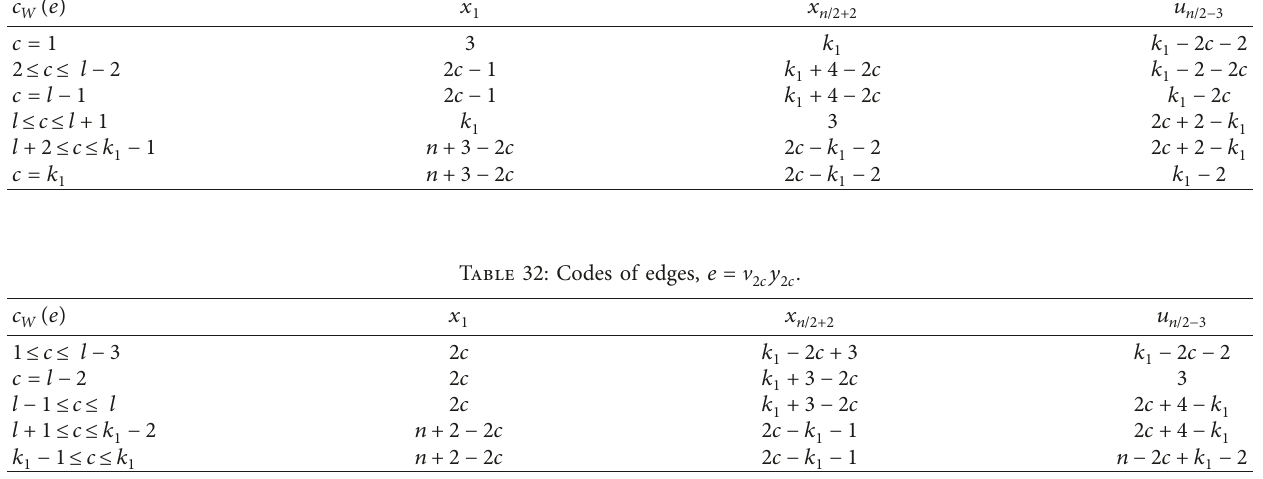
Table 31: Codes of edges, e � v